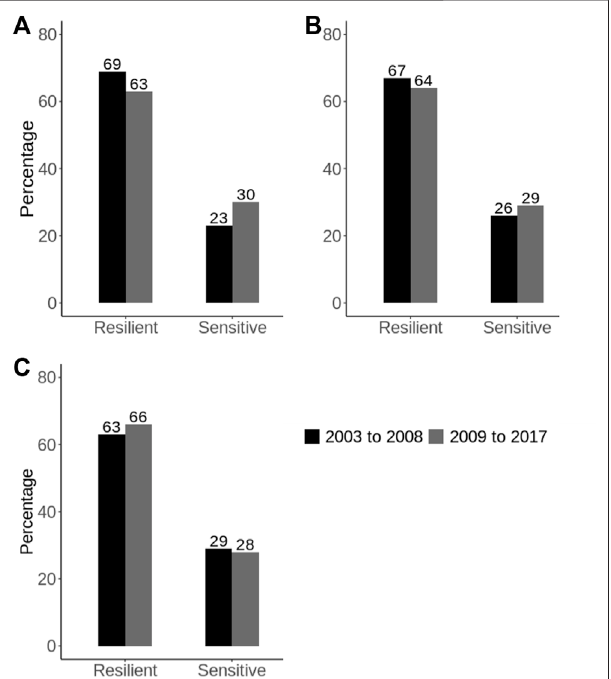
FIGURE 4 | Comparing the percentage of heat stress resilient and sensitive bulls in Australia between earlier years (2003 – 2008) versus recent (2009 – 2017)years[Adaptedfrom(Cheruiyotetal.,2020)].Theheat-tolerance pro fi les of the bulls were de fi ned based on the reaction norms of their EBVs along the THI trajectory for heat tolerance milk (A) , fat (B) , and protein (C) yield slope